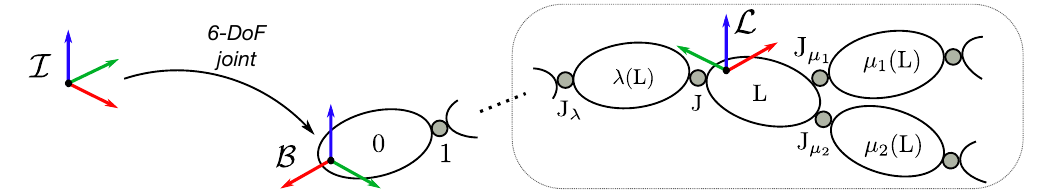
Figure 1. Graphical representation of the system topological order for links and